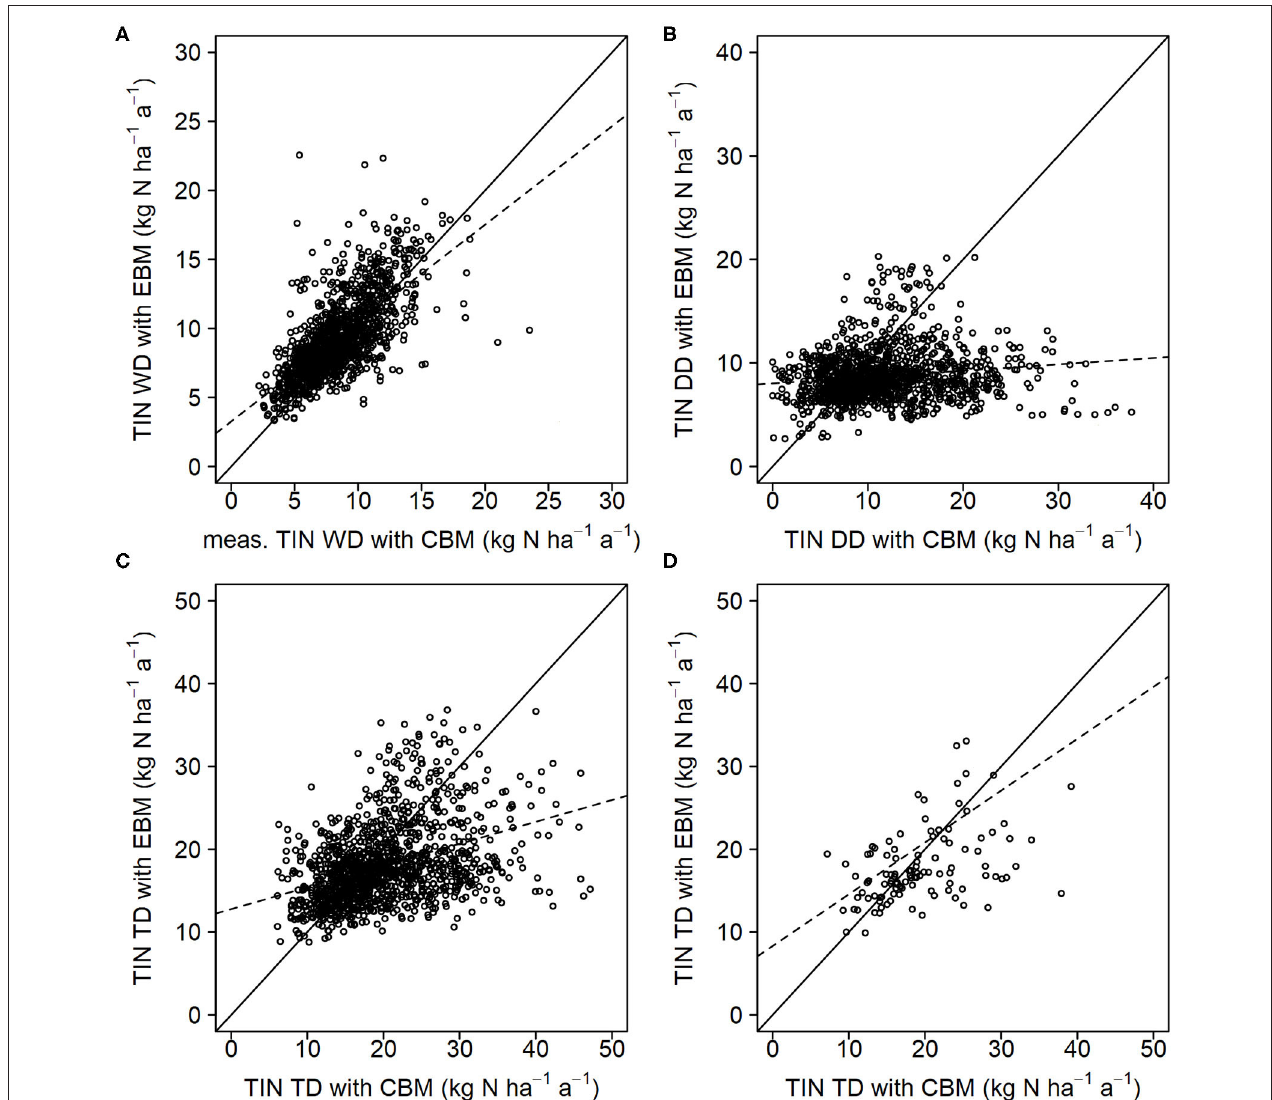
FIGURE 3 | Comparison of yearly wet deposition (WD) (A) , dry deposition (DD) (B) , and total deposition (TD) (C) of total inorganic nitrogen (TIN) between emission based (EBM) and canopy budget method (CBM) ( n = 1,237 site-years from 104 sites). (D) TD with site-specific mean values. The solid black line represents the 1:1 line and the dashed line represents the linear regressions line. All statistical parameters are given in Table 6